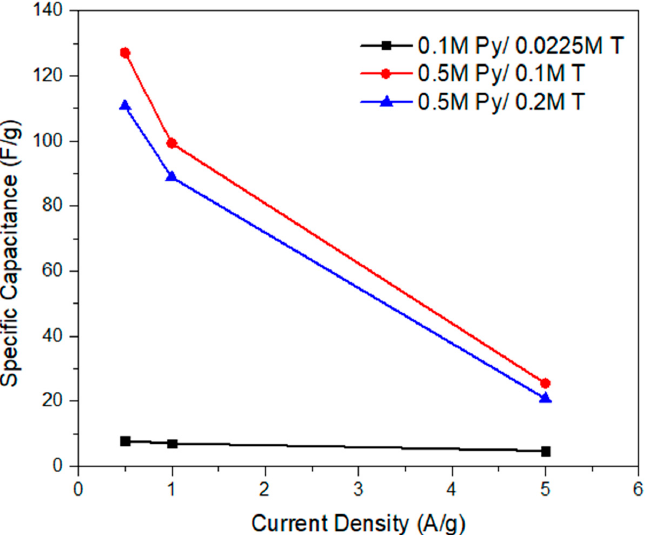
Figure 8. Specific capacitance of composite electrodes electrodeposited with PPy measured by using GCD at 0.5 A/g, 1 A/g, and 5 A/g.